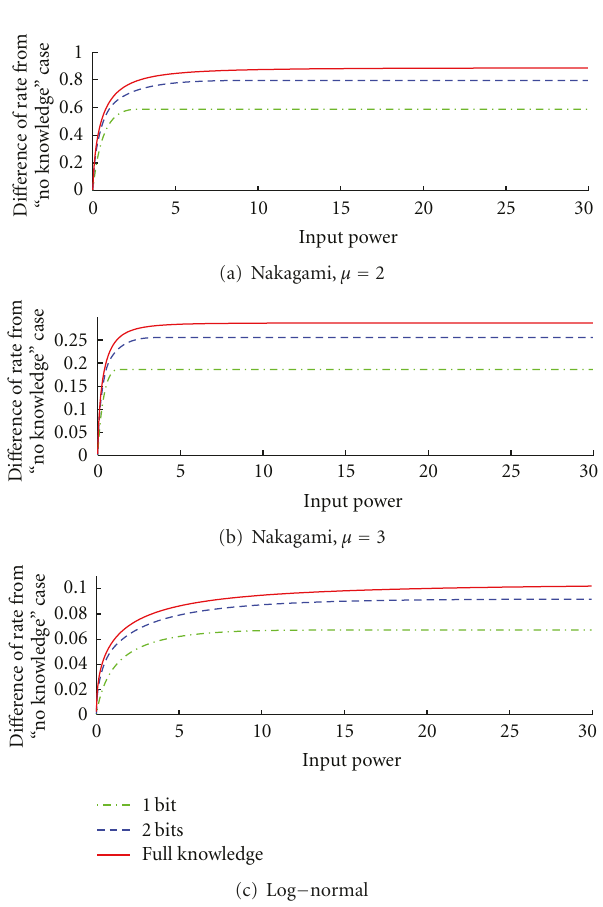
Figure 6: Increase in channel capacity relative the “no knowledge” lower bound using optimal quantization.